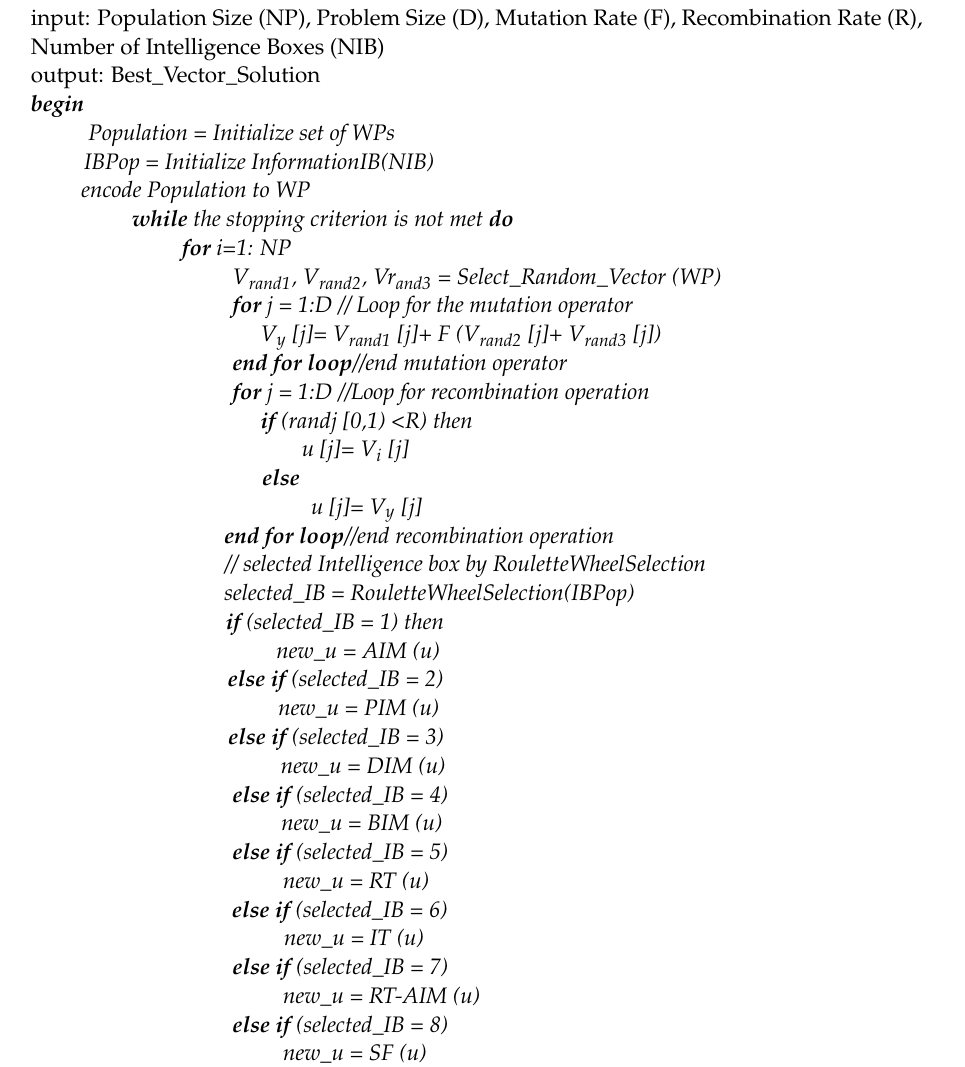
Algorithm 1: Artificial Multiple Intelligence System